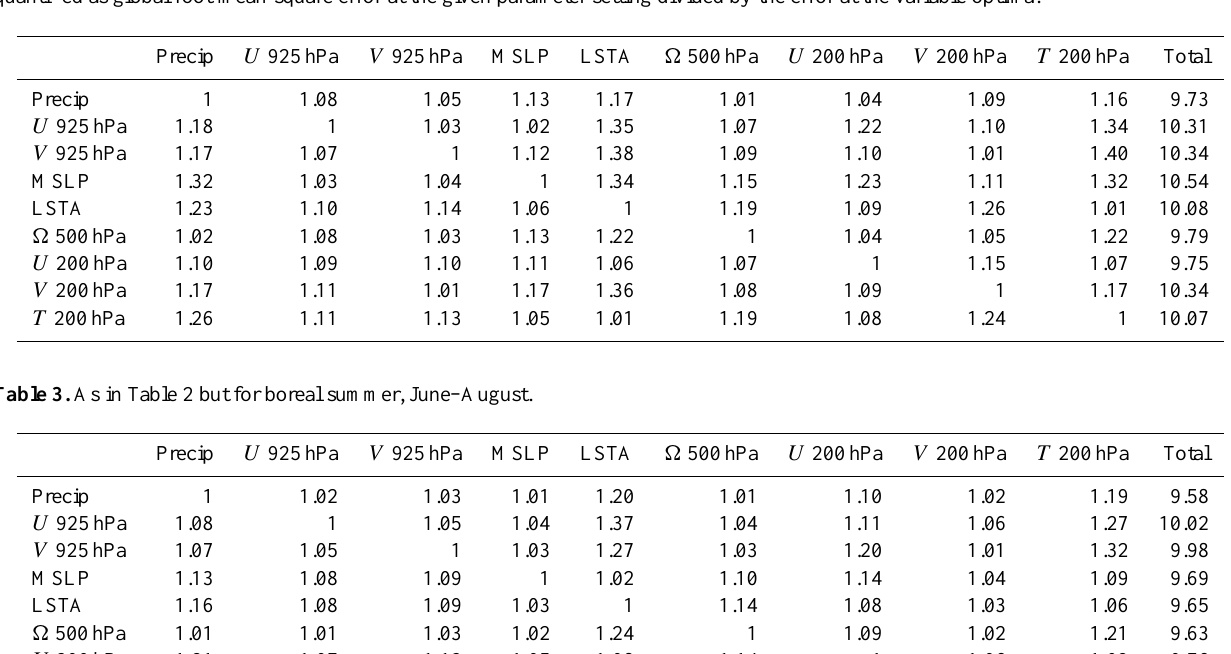
Table 2. Trade-offs associated with optimizing one variable at a time according to the setting in Table 1 for nine climatic variables in boreal winter, December–February. The last column provides the sum of the trade-offs given the optimization of one given variable. Trade-offs are quantified as global root-mean-square error at the given parameter setting divided by the error at the variable optima.